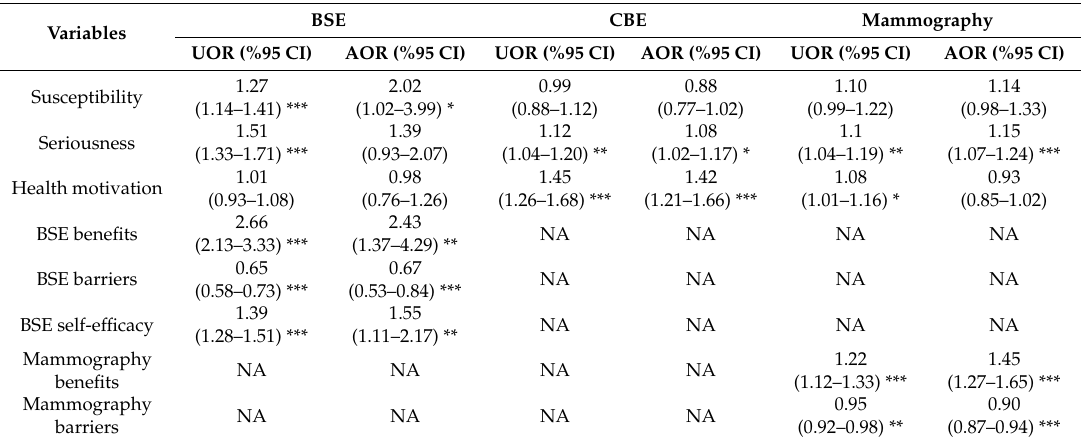
Table 5. The relationship between the participants’ health beliefs and screening behaviors according to multivariate binary logistic regression